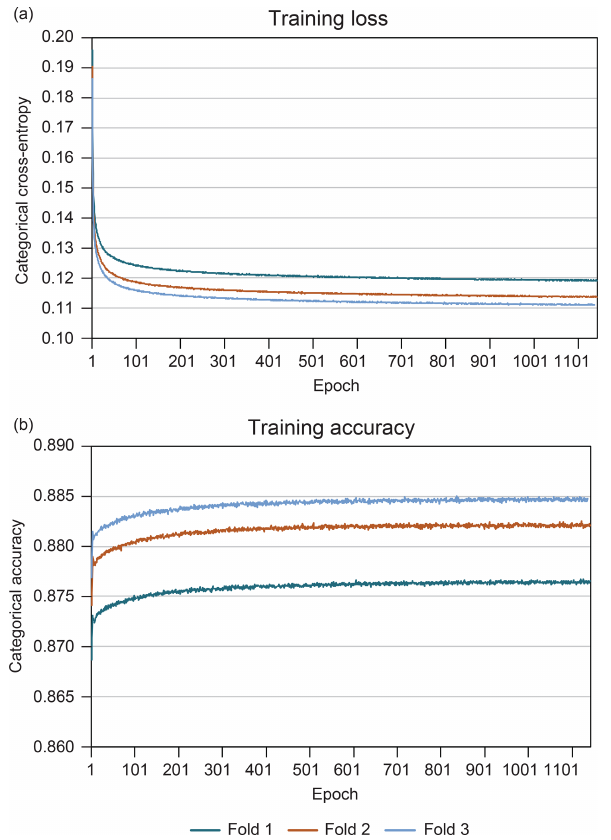
Figure 3. The training loss (a) and training accuracy (b) for each training epoch of the DL-FRONT NN over three cross-validation folds.